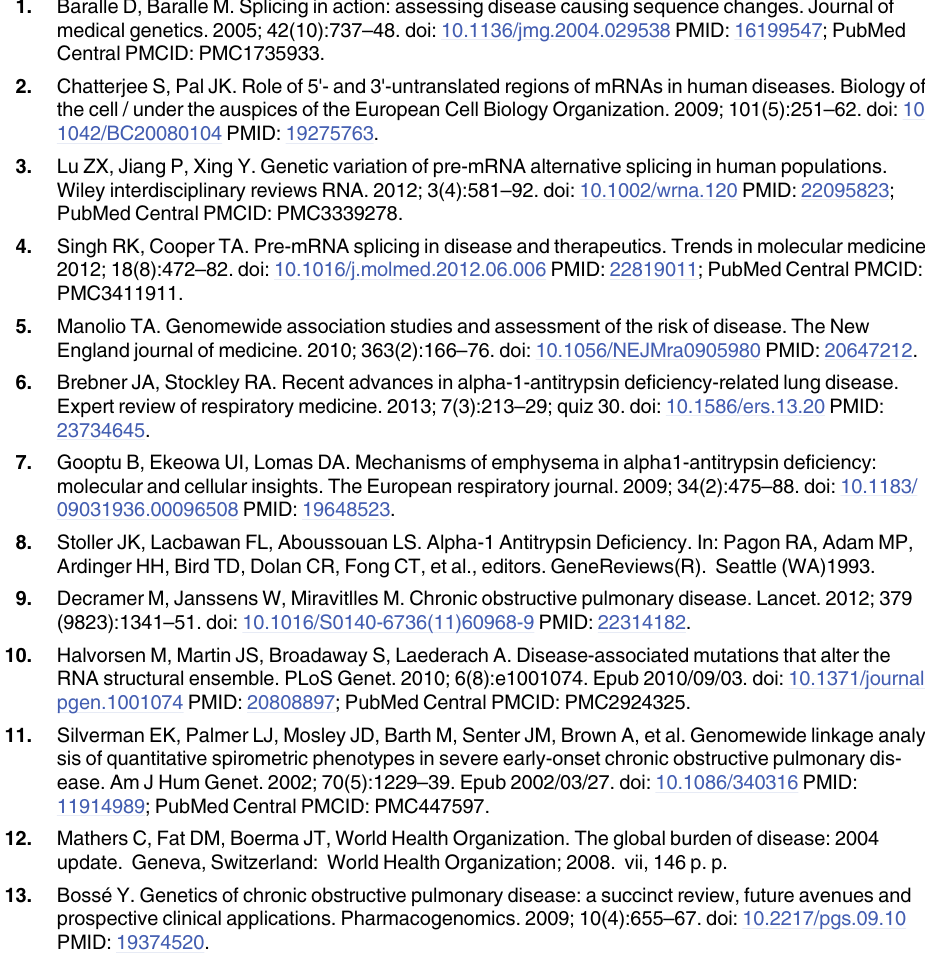
S11 Table. FPKM expression of exons stratified by expression in COPD and control